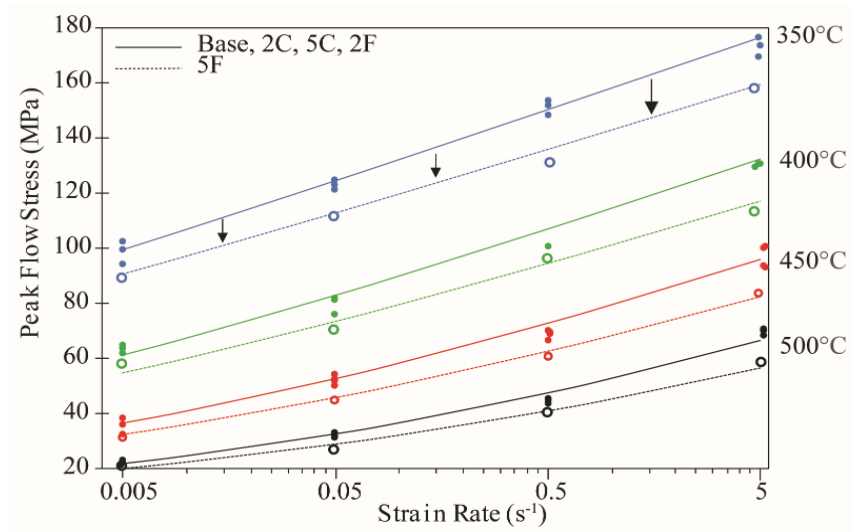
Figure 10. Peak flow stress data for MMC materials plotted versus strain rate. Experimental data points superimposed on Zener-Hollomon calculated curves (solid and dashed lines).